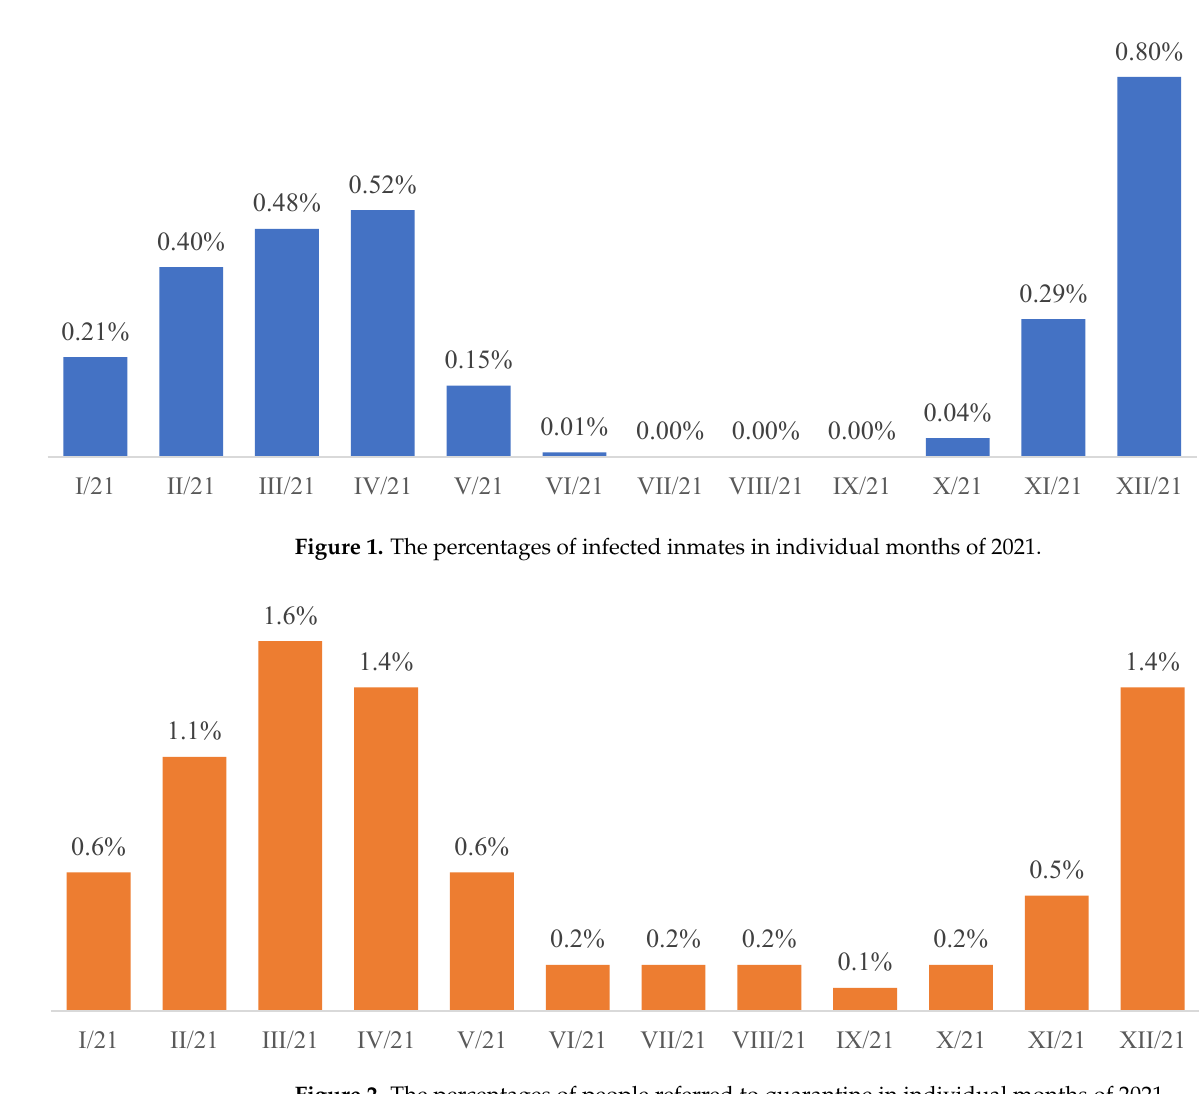
Figure 2. The percentages of people referred to quarantine in individual months of 2021.